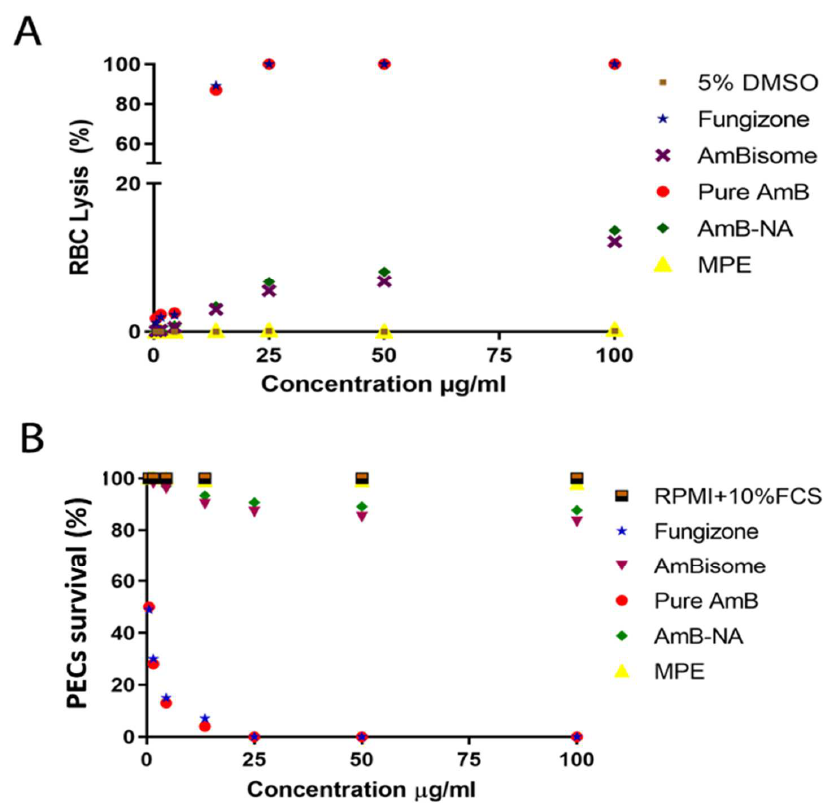
Figure 3. As-synthesized AmB-NA evoked minimal toxicity against living cells. ( A ) The extent of damage incurred to healthy RBCs upon exposure to AmB-NA was measured as a percentage lysis of total RBCs. Isolated RBCs (2 × 10 8 cells/mL) were incubated with as-formed AmB-NA to assess the intrinsic toxicity of the later on animal cells. ( B ) Assessment of as-synthesized AmB-NA mediated toxicity on PECs-derived macrophages. The cells were exposed to AmB-NA for a period of 24 h. MTT assay was employed to assess the toxicity of as-synthesized AmB-NA; the extent of the killing of the treated cells was normalized to the control untreated cells. Data are reported as means ± SE of the quadruplet set of the experiment.